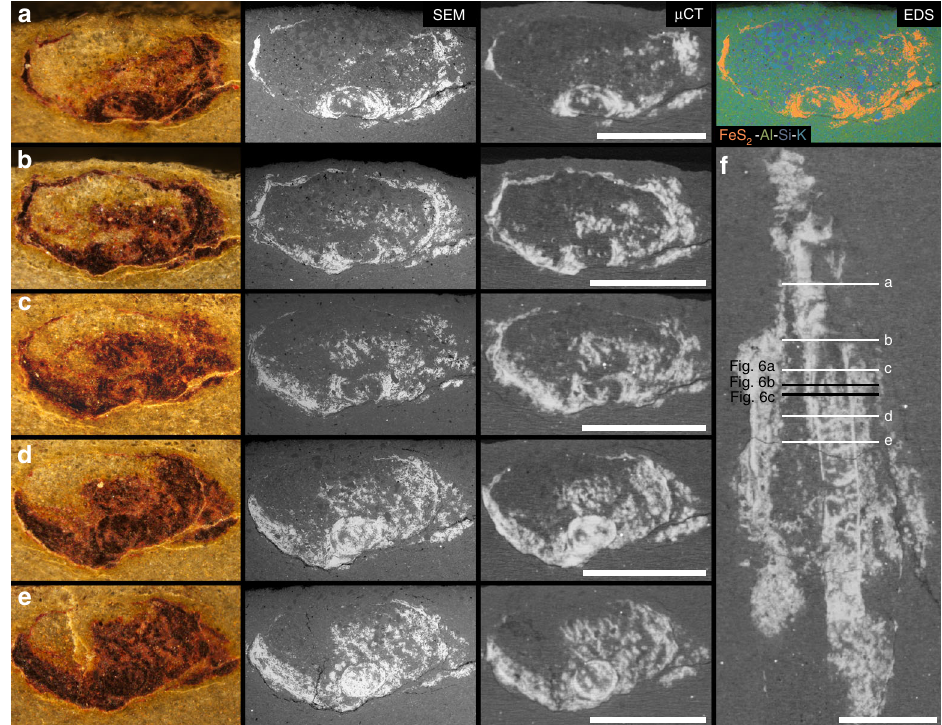
Fig. 5 Cross-sectional morphology of preserved cloudinomorph soft tissue. Cross-sections revealed by serial grinding of specimen USNM-WCF_001 illustrated in Fig. 4 (sample USNM-WCF_001); portion of the fossil chosen for grinding shown in Fig. 4e. a – e Light and SEM images matched with approximately equivalent µ CT tomographic slices (differences in obliquity imposed during serial grinding). Far right in a shows tube and gut pyritization via